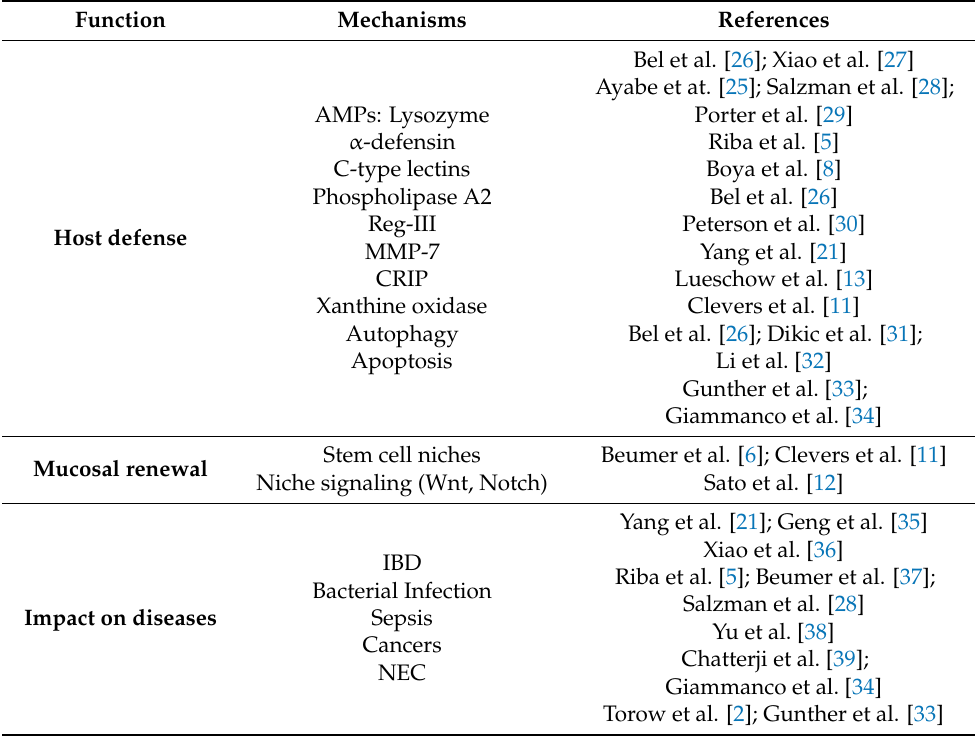
Table 1. Role of Paneth cells in the intestinal epithelium homeostasis and